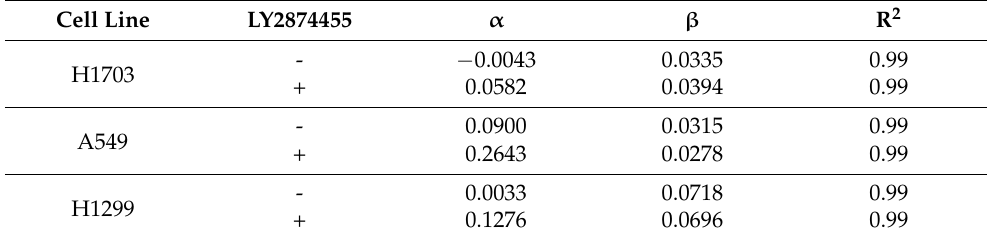
Table 2. Radiosensitizing effect of LY2874455 at each radiation dose calculated based on the linear– quadratic-model-derived surviving fractions.